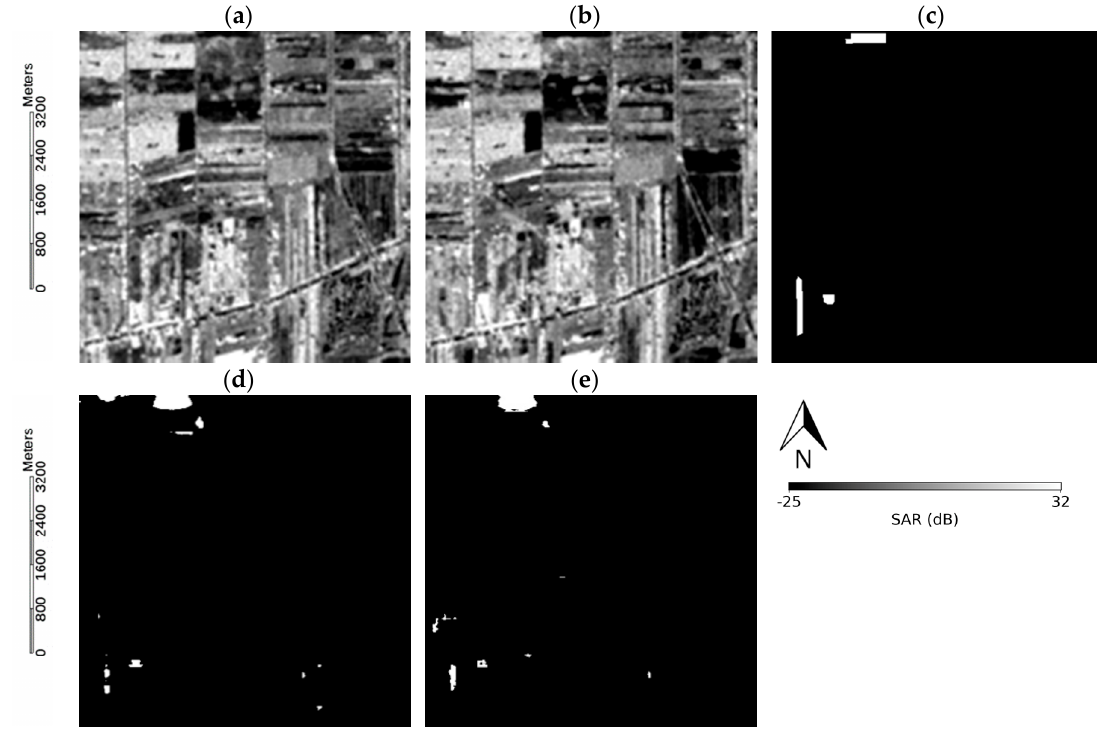
Figure 10. Results of the Bangkok site in the first area at 14°1’2.26”N 100°41’15.99”E. The size of each image is 6 × 6 km (for SAR pairs 12 January 2009/21 November 2009: ( a ) Time 1 SAR image; ( b ) Time 2 SAR image; ( c ) ground truth; ( d ) result of U-net; ( e ) proposed result).